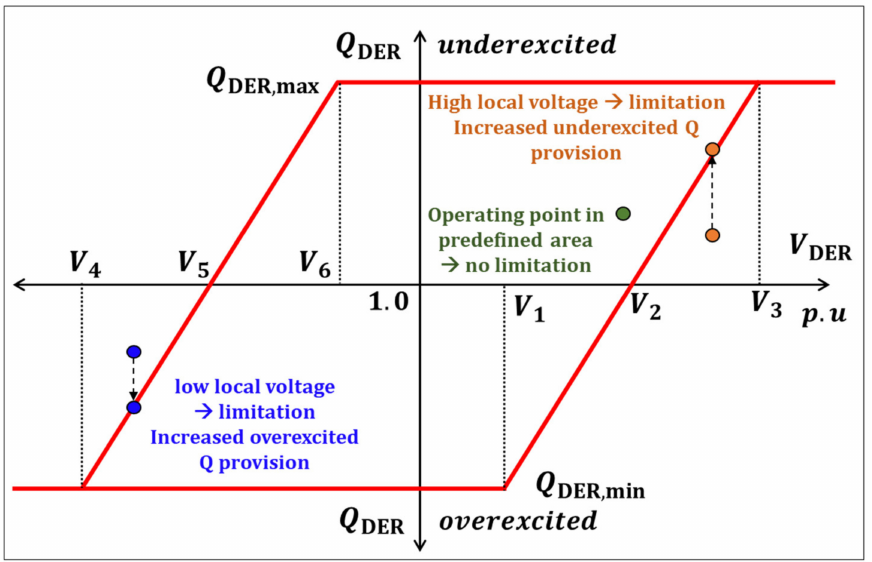
Figure 5. Applied extended Q(V) limitation curve for the voltage